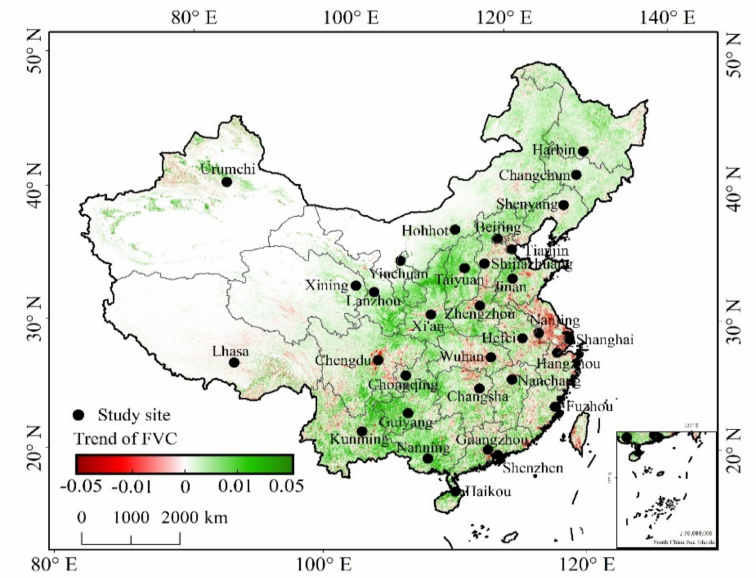
Figure 3. Spatial distribution of vegetation coverage trends from 2001 to